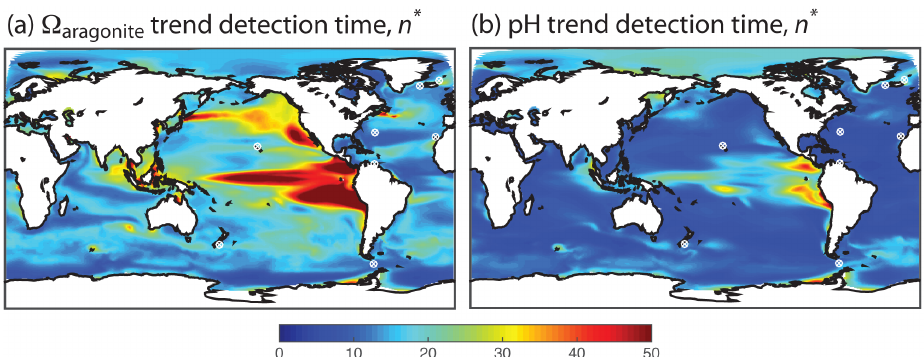
Figure 5. Model-estimated length of time series in years needed to detect (a) an (cid:127) aragonite trend of − 0.0078yr − 1 , and (b) a pH trend of − 0.0018yr − 1 with at least 90% confidence. White circled xs indicate the locations of the time series stations discussed in Bates et al. (2014).